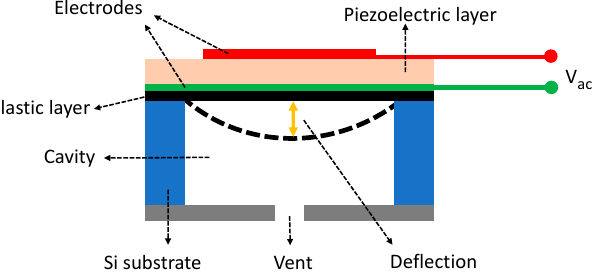
Figure 16. Typical structure of a flexural vibration mode pMUT in a cross-sectional view.